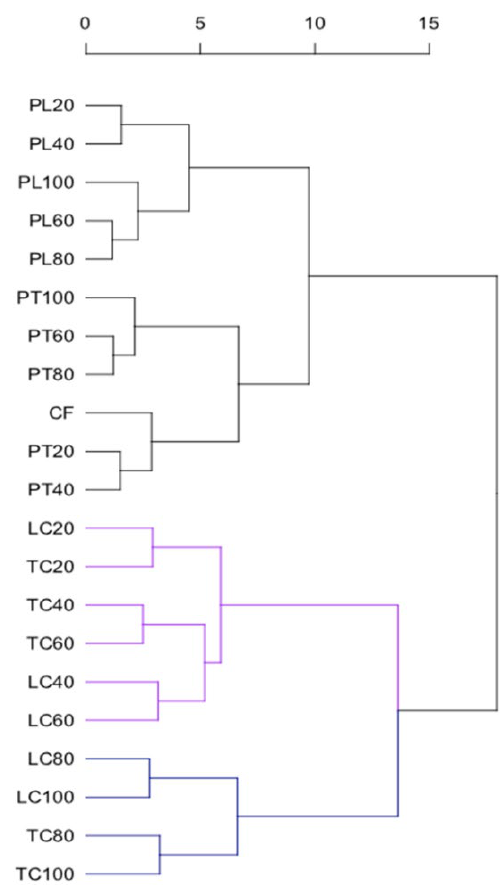
Figure 2. Dendrogram obtained by hierarchical cluster analysis (HCA) of the data of the different parameters studied in the growing media and lettuce seedlings. The x -axis represents the square Euclidean distances; PL: palm leaves; PT: palm trunk; LC: palm-leaf-derived compost; TC: palm- trunk-derived compost.